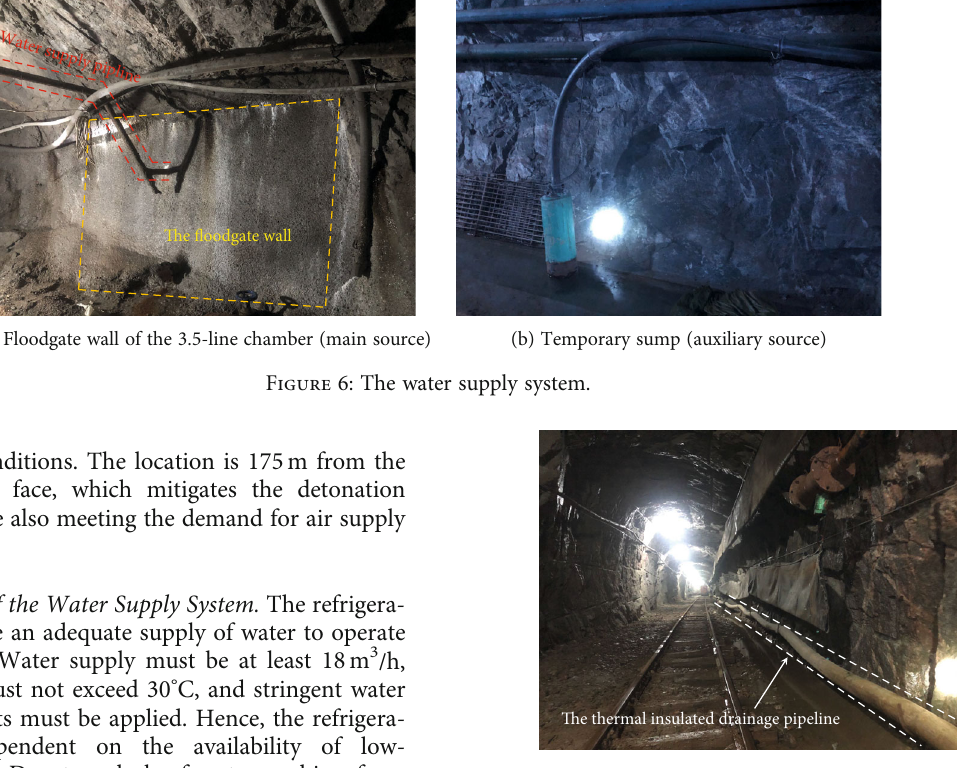
Figure 7: The thermal insulated drainage pipeline.